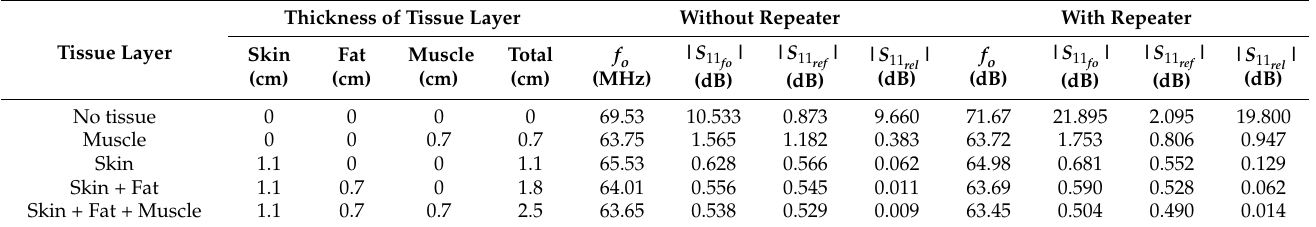
Table 2. Magnitude of relative return loss ( S 11 thicknesses of porcine tissue